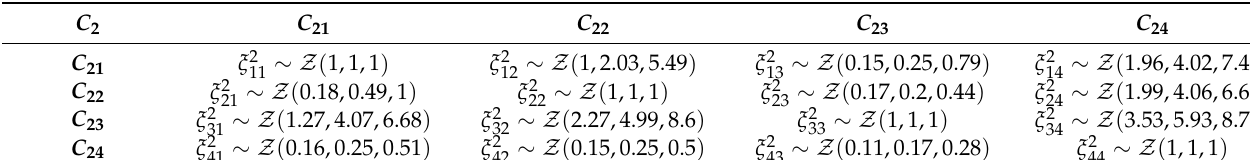
Table 9. Uncertain matrix for criteria C 21 , C 22 , C 23, and C 24 .